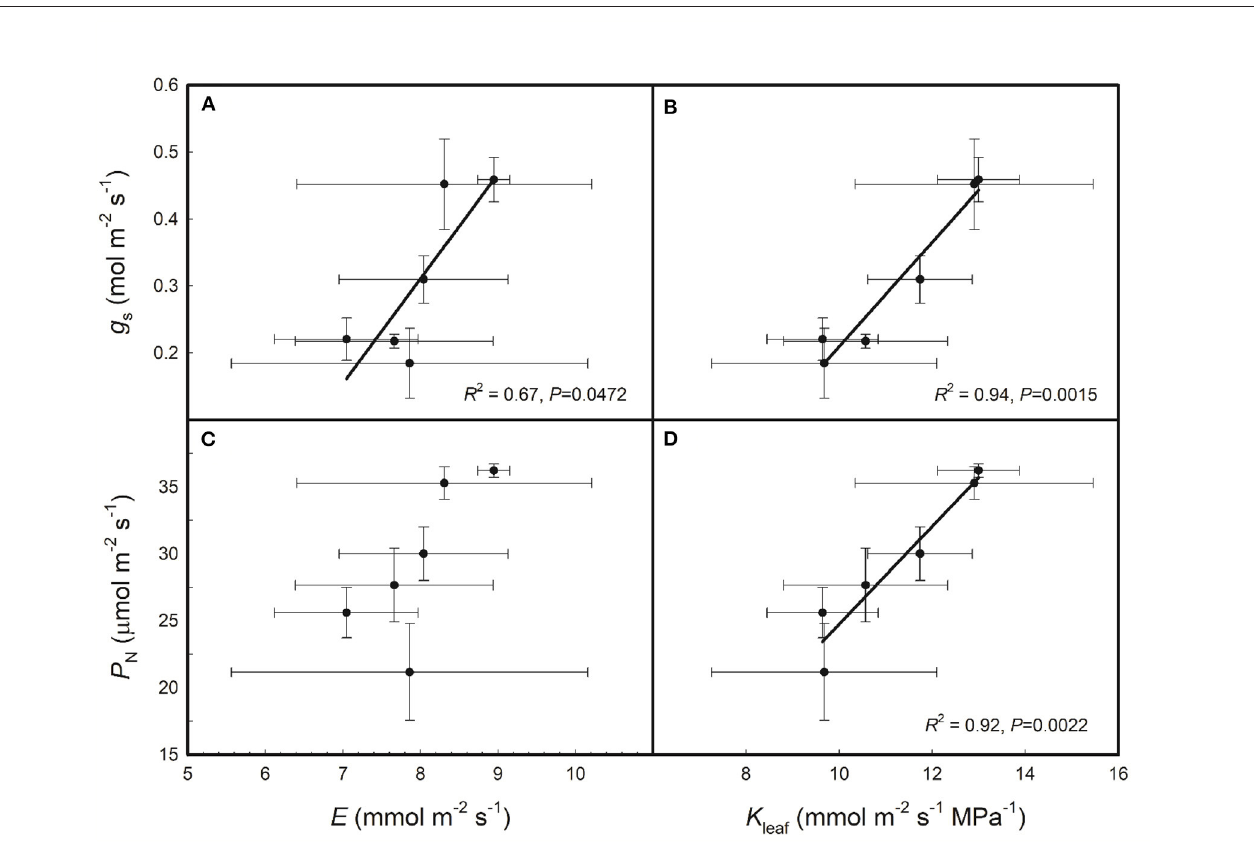
FIGURE 2 | Relationships of stomatal conductance ( g s ) and net photosynthetic rate ( P N ) with leaf transpiration rate ( E ) (A,C) and leaf hydraulic conductance ( K leaf ) (B,D) across the six rice genotypes. Data are shown as the means ± SD of three replicates.